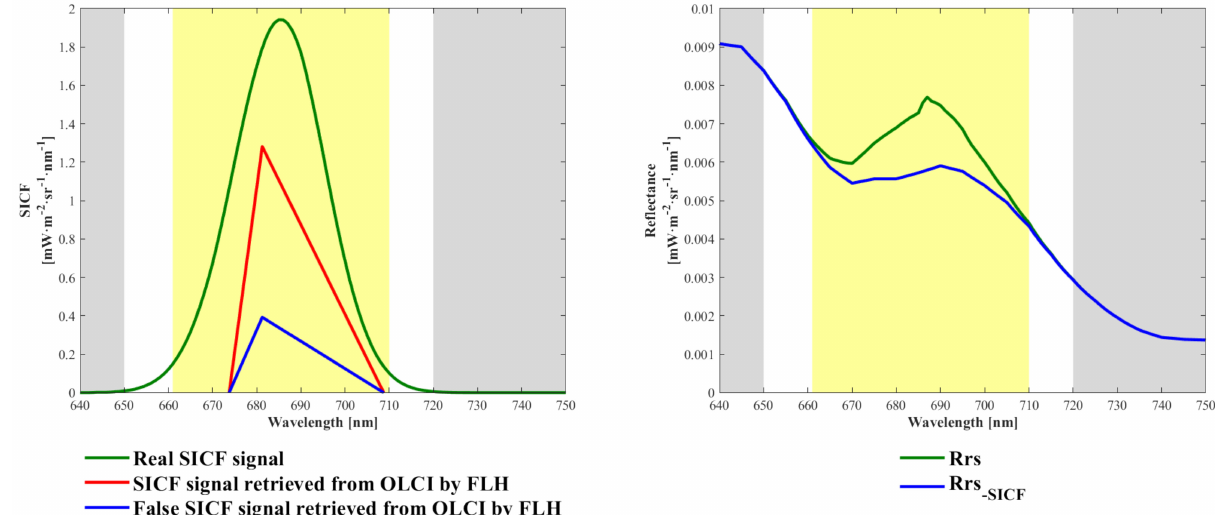
Figure 11. Left: SICF retrieved from the simulated validation data, using Equation (14) (green line), SICF retrieved from simulated validation data convolved to the OLCI ISRF (red line), and SICF retrieved from simulated validation data “without SICF” convolved to the OLCI ISRF (blue line). Right: Rrs spectrum of SICF in left figure (green line). Rrs − SICF spectrum of false SICF in left figure (blue line).